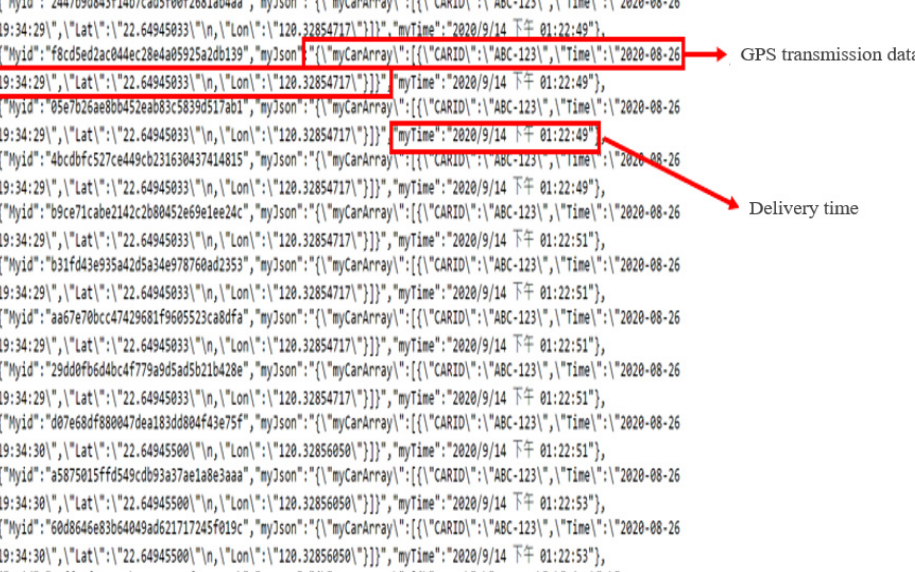
( b ) Figure 29. GPS value test chart of a stopped vehicle: ( a ) current situation of GPS value drift; ( b ) current status of GPS value drift improved . In a driving test, an average moving speed is about 40 km/h. Figure 30 shows that movement tracking is performed at sampling intervals of 1 and 5 s. In Figure 30a, when the sampling interval is long, blind spots occur at the corner, resulting in a large deviation